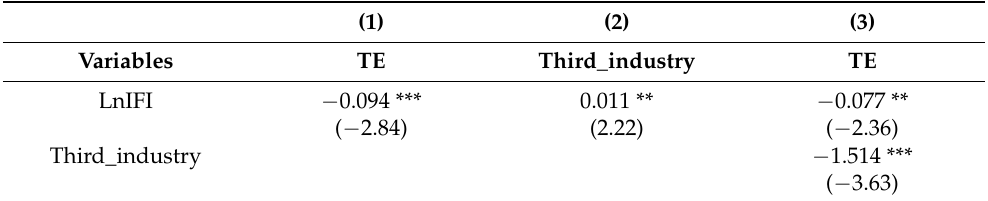
Table 8. Robustness check: fixed effect